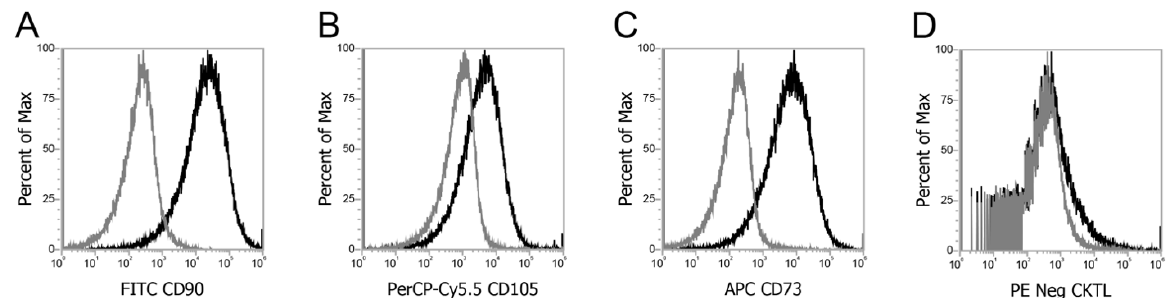
Figure 2. Surface phenotyping under flow cytometry for positive cell surface antigen expression for CD 90 ( A ), CD105 ( B ), and CD 73 ( C ) and absence of negative cell surface antigens in a negative cocktail of CD 34, CD 11b, CD19, and CD45, and HLA-DR ( D ) expression in bone marrow-derived MSCs.